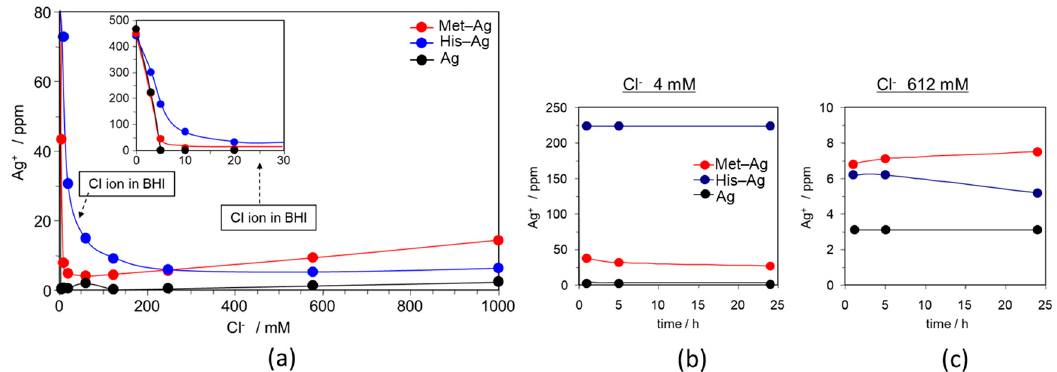
Figure 5. Silver ion measurements using atomic absorption spectrometry (AAS). ( a ) Silver ion concentration of Met–Ag, His–Ag, and Ag in different concentrations of chloride. ( b ) Silver ion concentrations of Met–Ag, His–Ag, and Ag over time in 4 mM Cl − solution. ( c ) Silver ion concentrations of Met–Ag, His–Ag, and Ag over time in 612 mM Cl − solution.